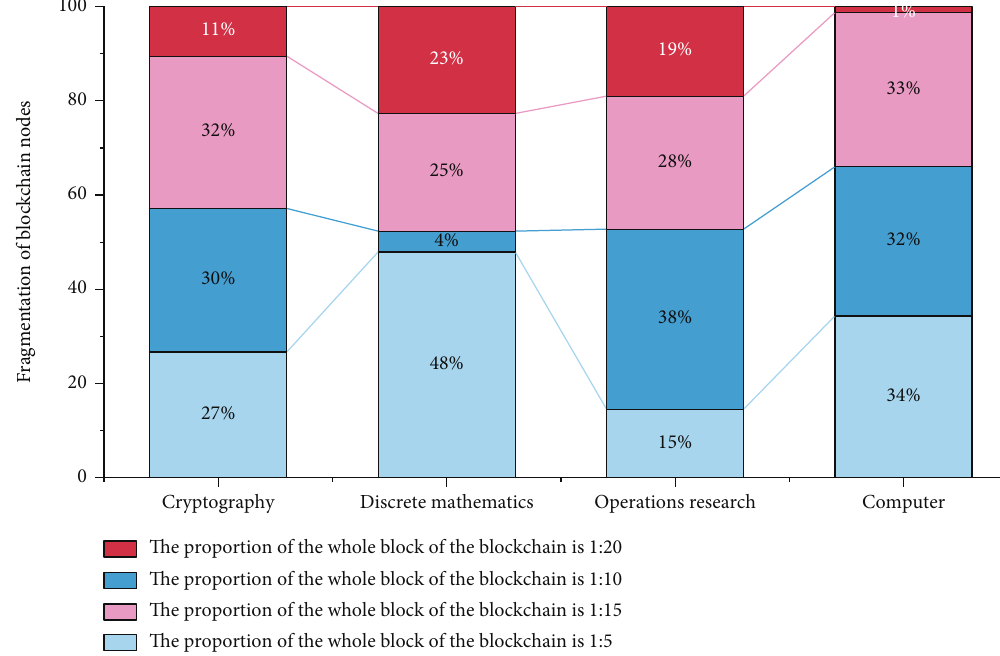
Figure 8: Sharding progress of di ff erent blockchain operations.